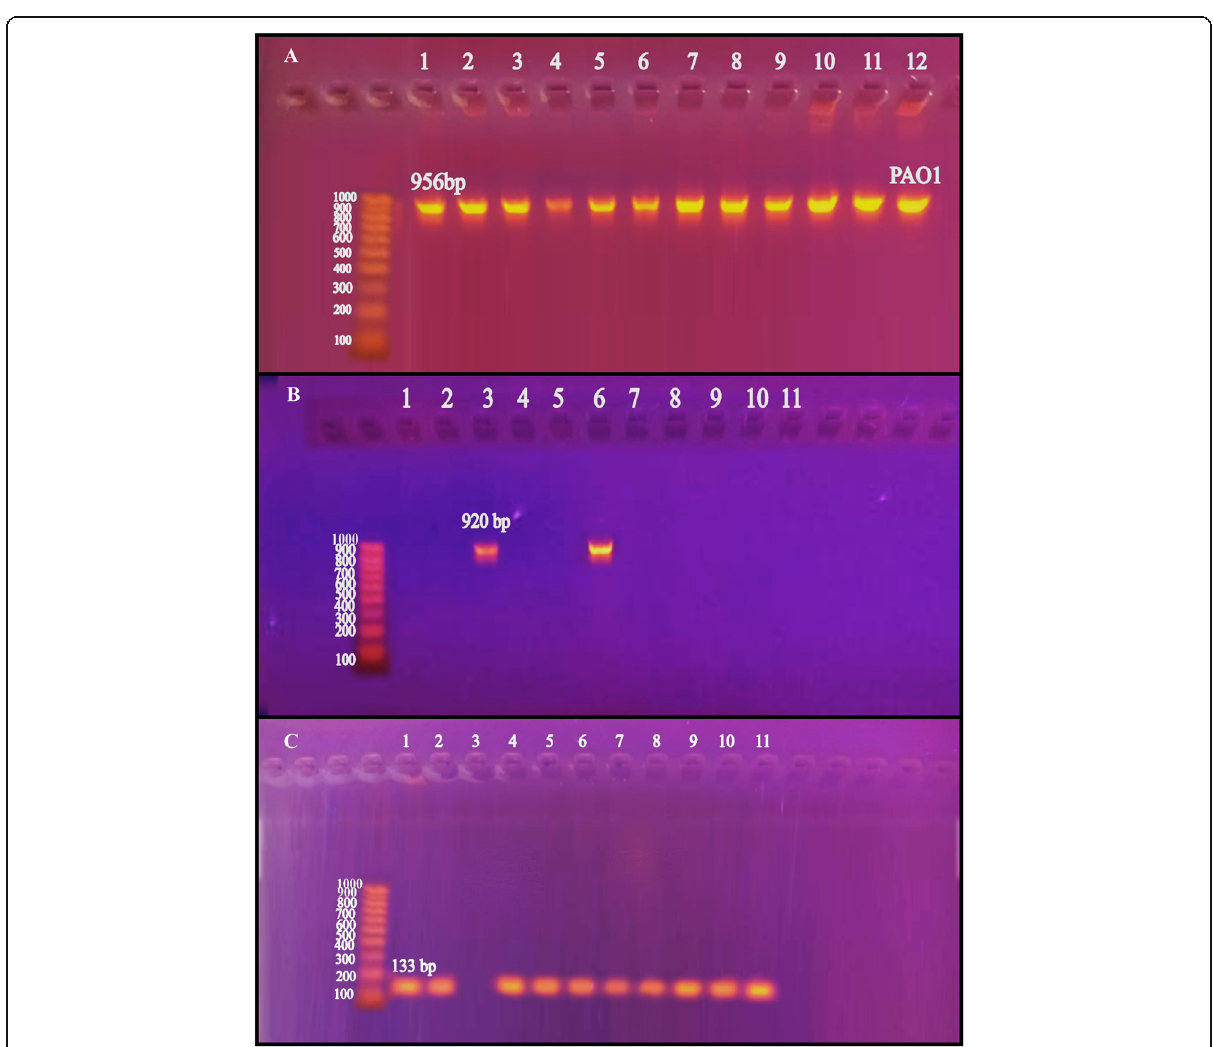
Fig. 4 PCR analysis of P. aeruginosa isolates on agarose gel electrophoresis ( a) PCR products for amplification-specific 16S rDNA region to P. aeruginosa . Lanes, 1-11: P. aeruginosa isolates; lane 12, PAO1 strain (positive control). b PCR products for amplification metallo-beta-lactamase gene encoding bla VIM-1. c PCR products for amplification metallo-beta-lactamase gene encoding bla